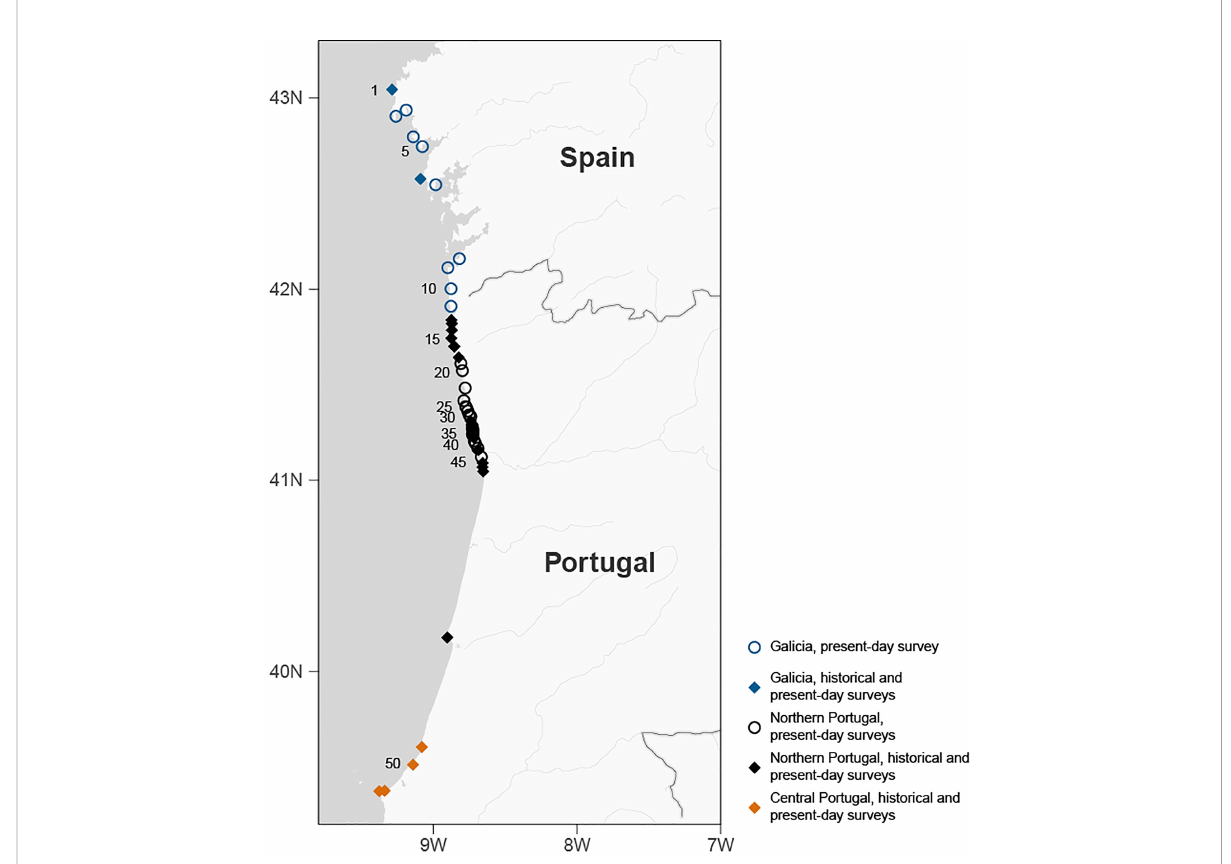
FIGURE 1 Map of the surveyed sites. Locations are numbered in multiples of 5, from the northernmost (1) to the southernmost site (52). For more details on the sites see Supplementary Table 2 . Blue symbols correspond to sites in Galicia, black symbols to sites in northern Portugal and orange symbols to sites in central Portugal. Open circles indicate locations only visited in 2020-2021 while closed diamonds indicate locations visited both in 2001-2005 and